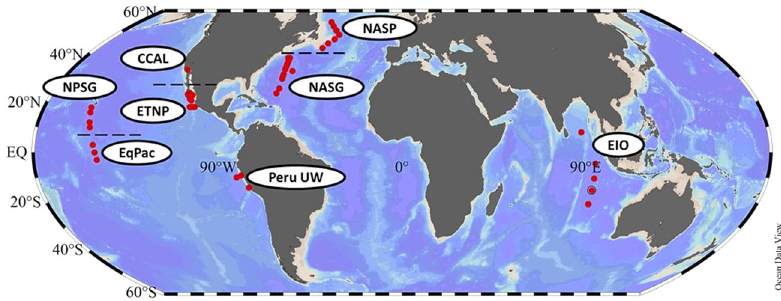
Fig. 1 Map of stations from which samples were collected and cell-sorted to quantify cellular macronutrient content. Circled abbreviations represent the regions: North Atlantic Subpolar (NASP), North Atlantic Subtropical Gyre (NASG), Coastal California (CCAL), Eastern Tropical North Paci fi c (ETNP), North Paci fi c Subtropical Gyre (NPSG), Equatorial Paci fi c (EqPac), Eastern Indian Ocean (EIO), and the Peru upwelling region (Peru UW). Speci fi c cruise details can be found in Supplementary Table 1. Dashed lines denote the separation between stations in neighboring regions. Map created in Ocean Data View (Schlitzer, R., Ocean Data View, http://odv.awi.de,